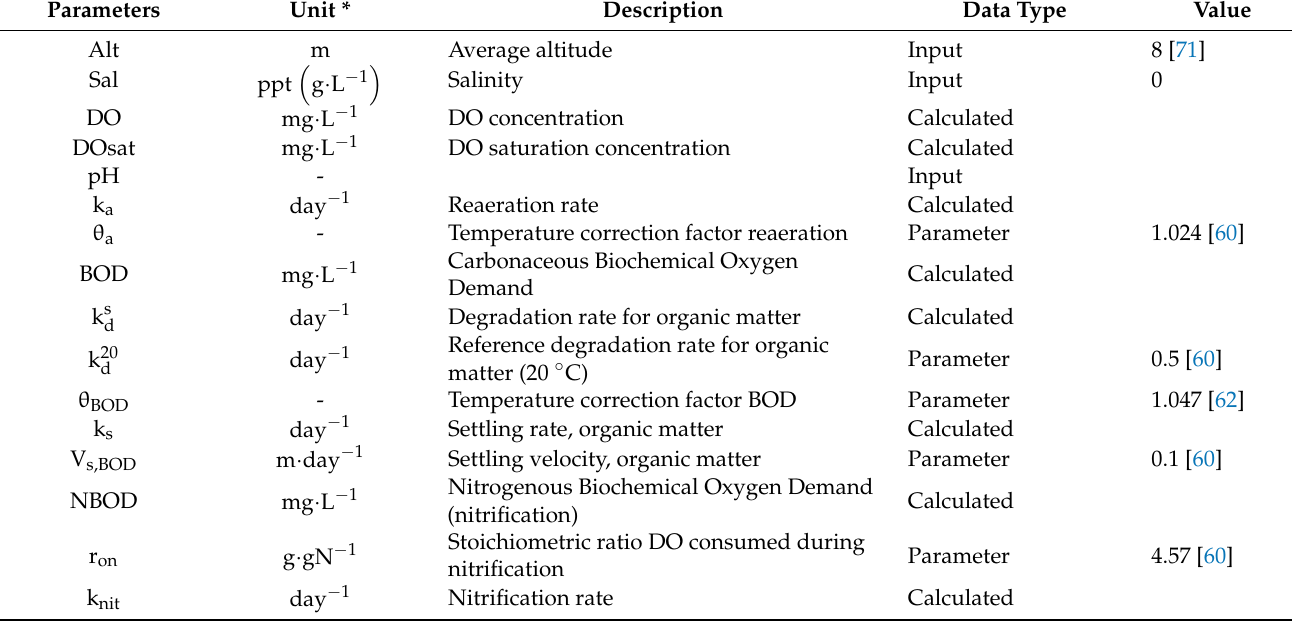
Table A5. Oxygen and